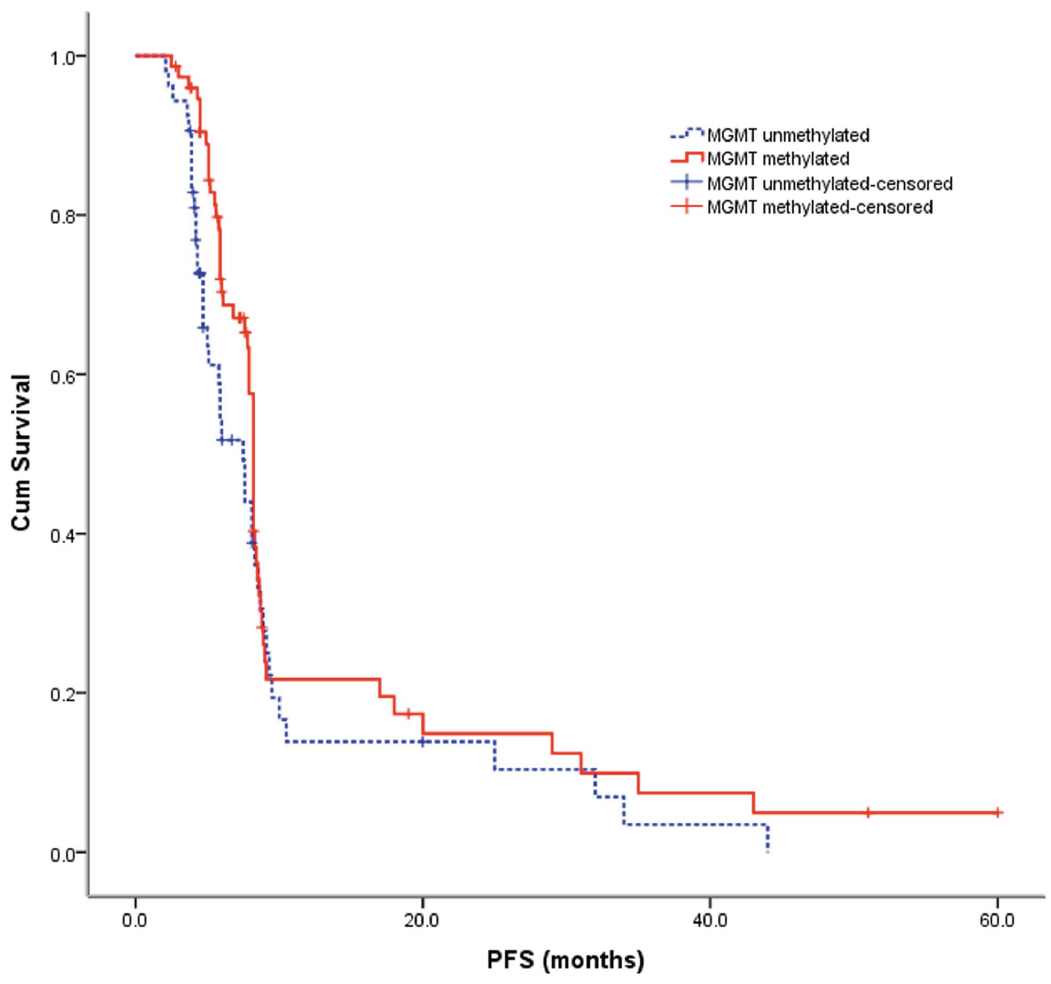
Figure 1. PFS after treatment in patients with methylated and unmethylated MGMT promoter glioblastomas (log-rank P=0.112). doi:10.1371/journal.pone.0107558.g001 PLOS ONE |